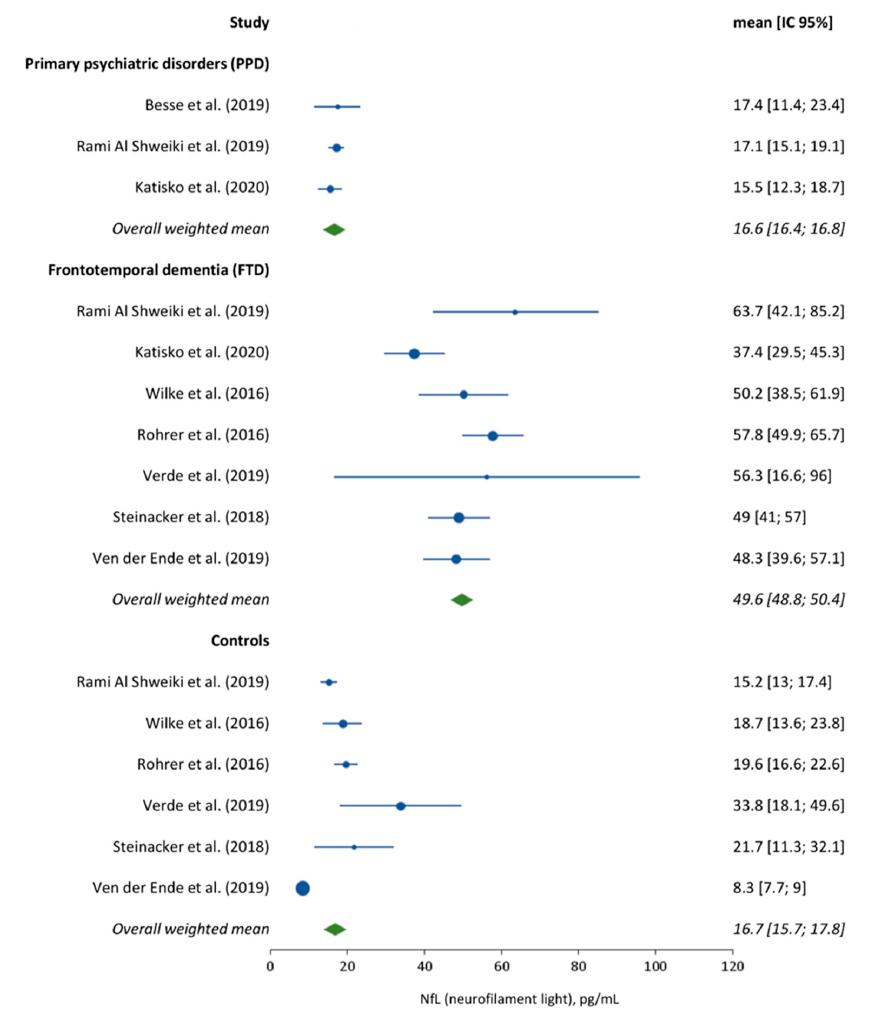
Figure 3. Forest plot analysis of serum NfL levels in FTD, PPD, and control patients.